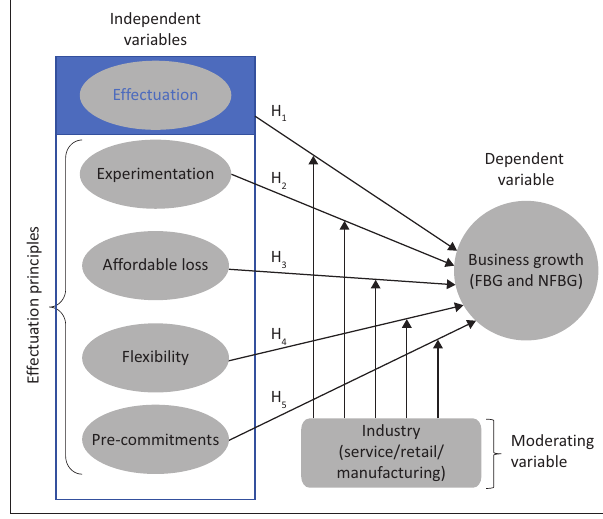
FIGURE 1: Conceptual model of the relationship between effectuation and business growth.